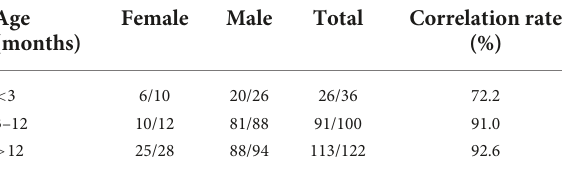
TABLE 5 24-h delayed film of barium enema and final pathological results in infants.